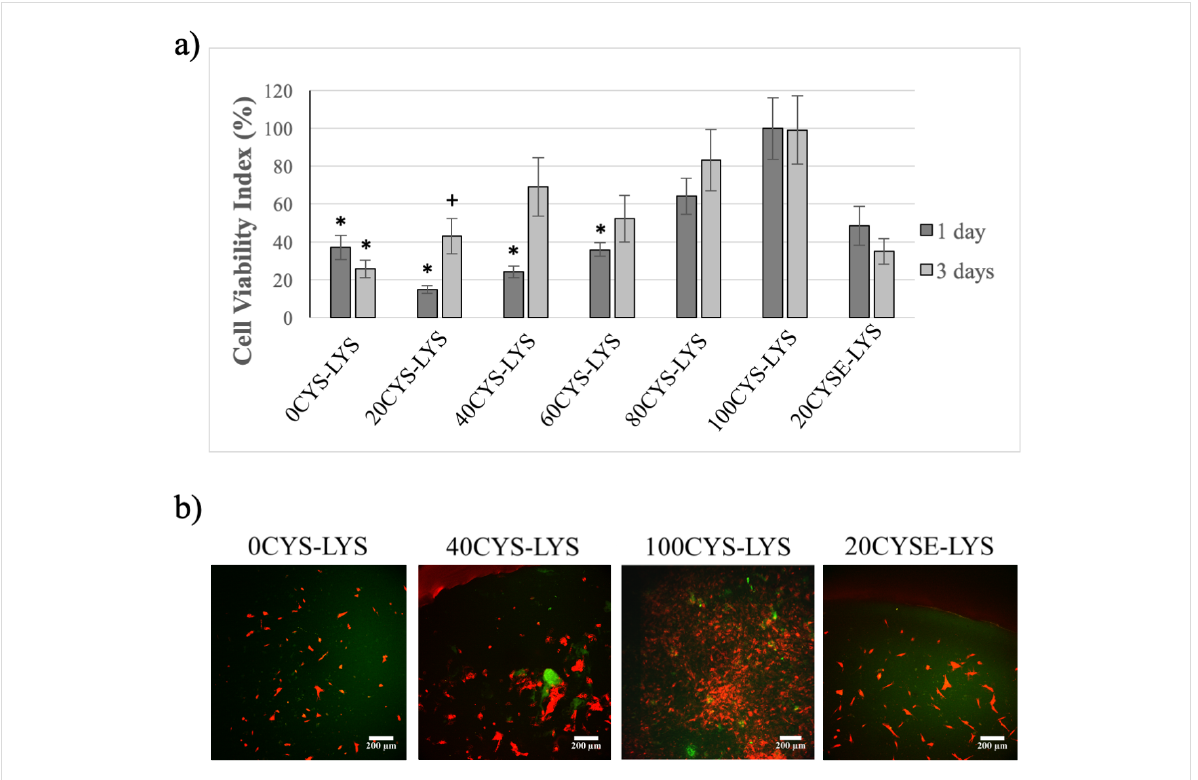
Figure 6: a) Viability of the PDLCs measured one and three days after seeding. The average viability value measured on the 100CYS-LYS gel on day one was considered as 100%. The cell viability indices are given as arithmetic mean ± SEM. * indicates p < 0.05 compared to the value of 100CYS- LYS at the corresponding time. + indicates p < 0.05 compared to the value of 100CYS-LYS on day one. b) Two-photon microscopic images of the PDLCs on the different hydrogels after three days. The scale bar indicates 200 μ m. Each photomicrograph was taken at the same